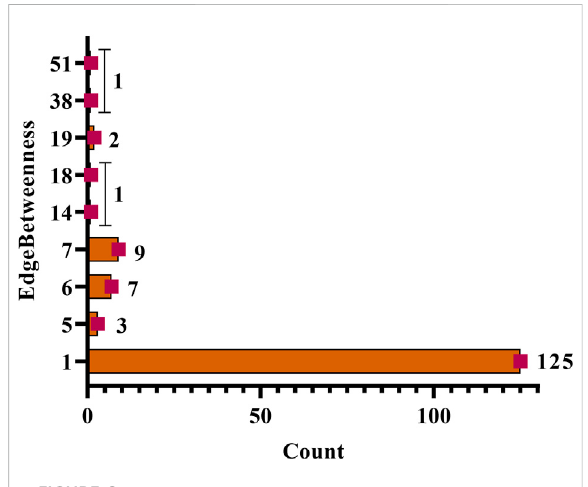
FIGURE 6 Edgebetweenness of network interaction and node interaction count. The highest edge betweenness was 51 (1 interaction) and the lowest was 1 (125